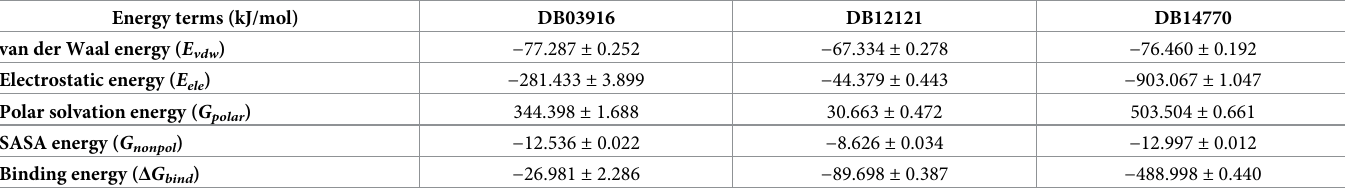
Table 3. Free energy calculations for the best ligands after MD simulations.